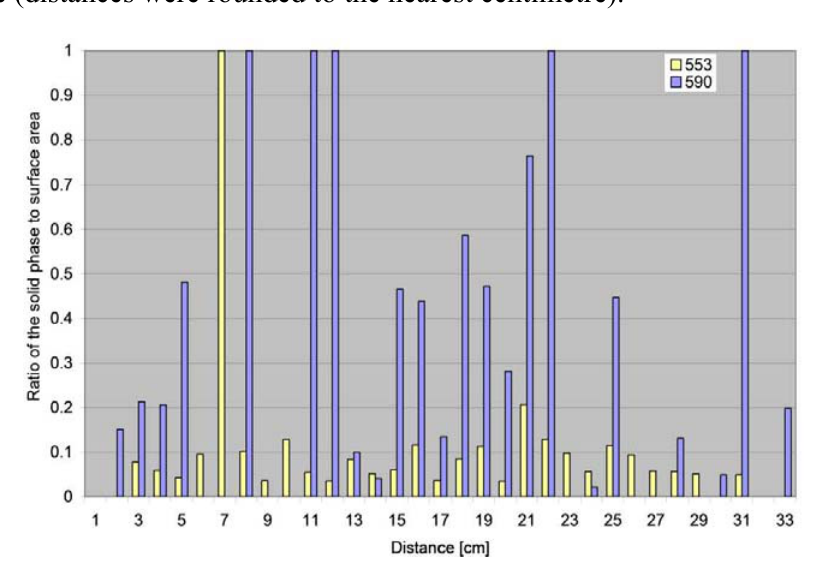
Figure 16. The ratio of the solid phase to the surface area of the splash track in relation to the distance (distances were rounded to the nearest